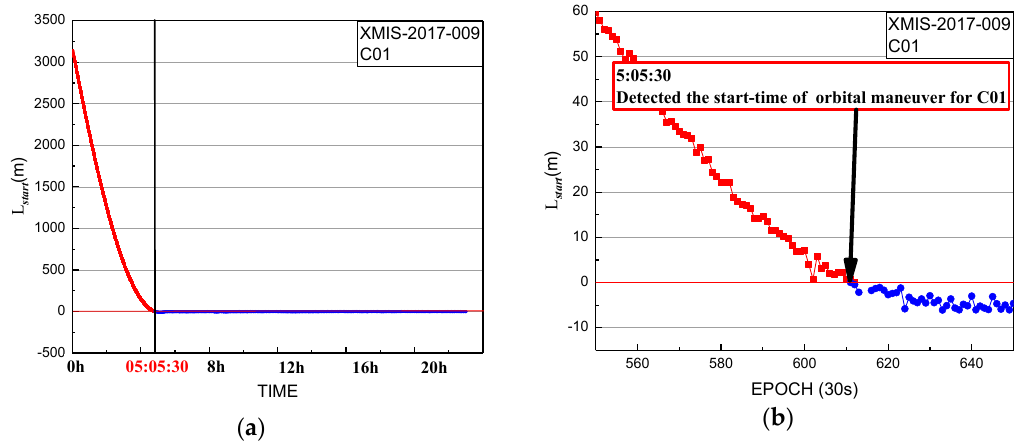
Figure 4. Start time factor of XMIS station for C01 on 9 January 2017: ( b ) detailed information from graph in ( a ).